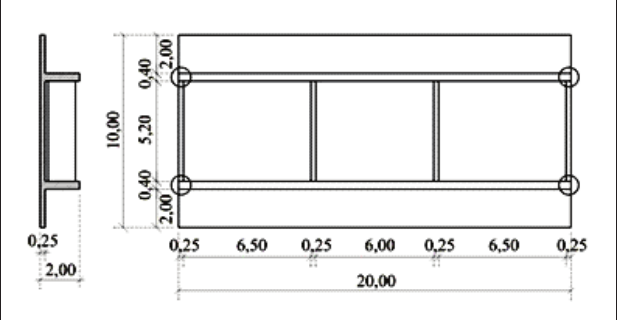
Figure 7 – Model with finite elements of bars and shells (MENDES [ 1 ])